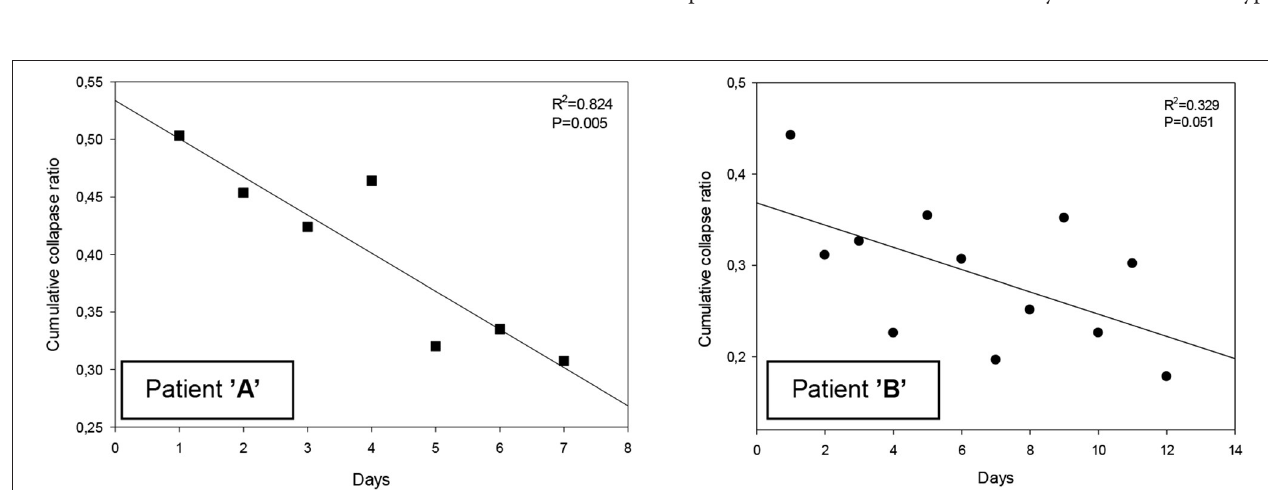
FIGURE 4 | (A,B) Cumulative collapse ratio following PEEP